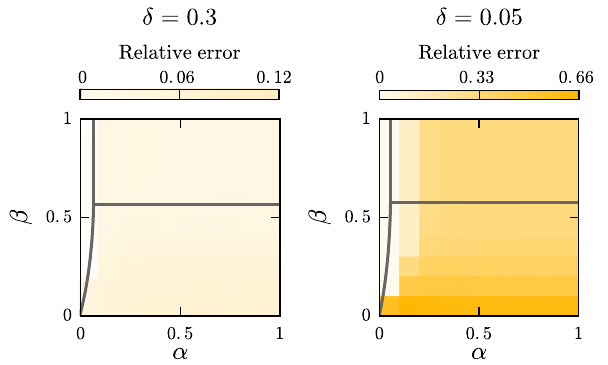
FIG. 18. Relative deviation of the density species fraction from δ for the special case W ¼ 13 lanes and L ¼ 512 sites. Color denotes simulation results for the relative deviation and thus the error that is made when assuming a density species fraction of value δ . Lines indicate the phase boundaries as predicted by our theory.